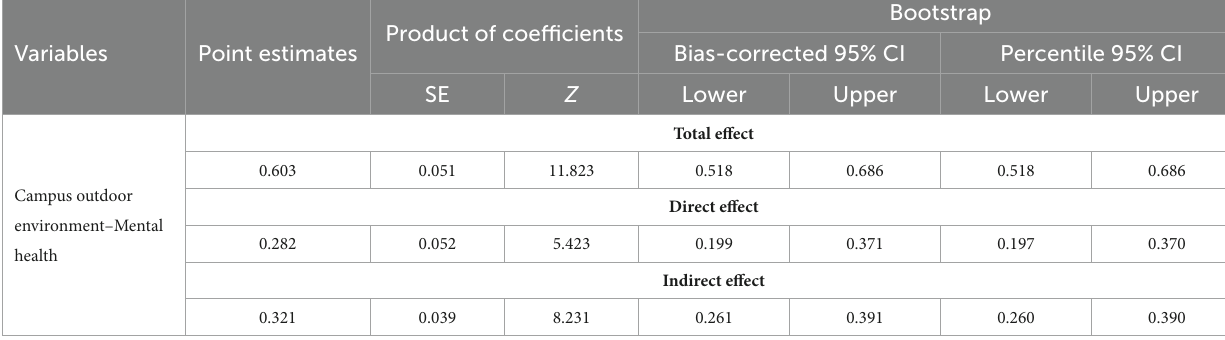
TABLE 7 The standardized effect value of the full sample